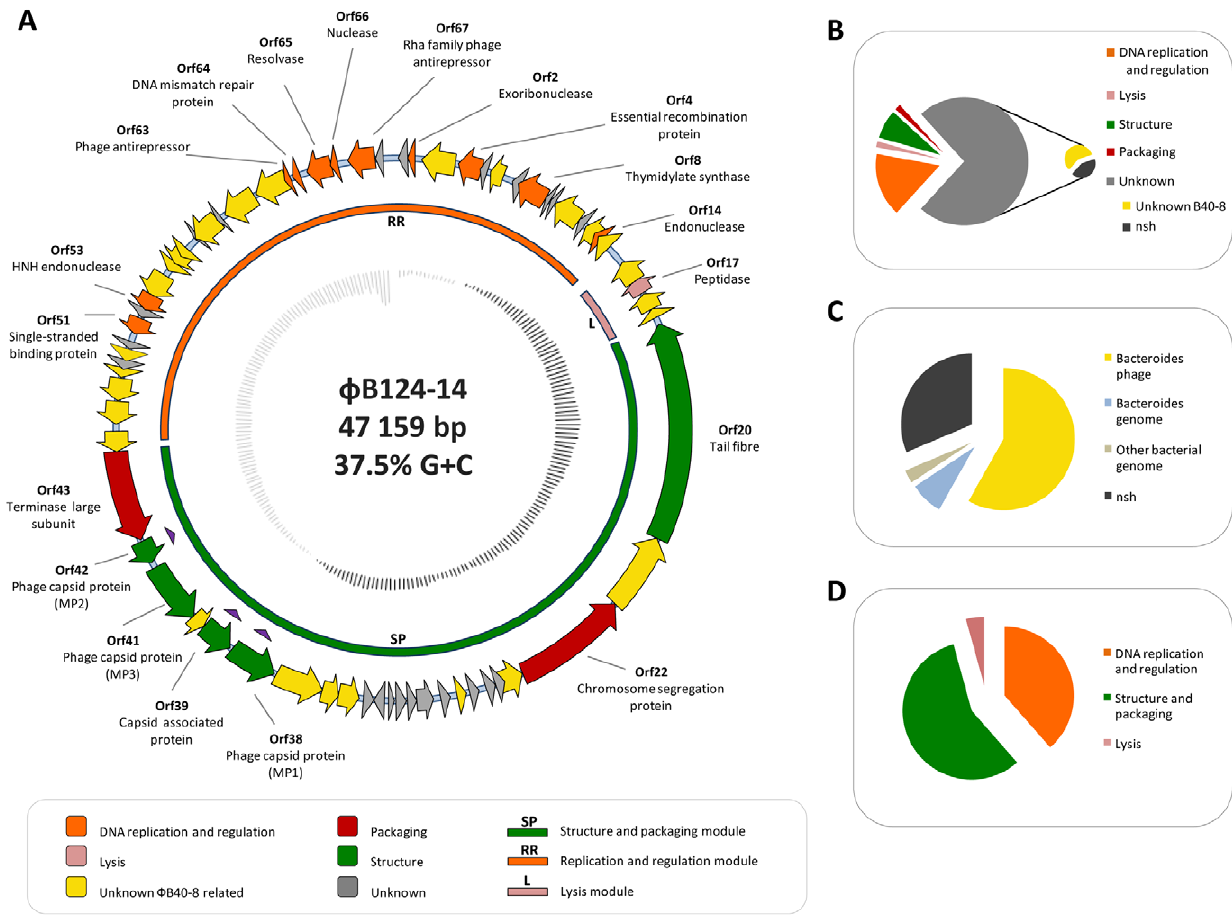
Figure 2. Architecture and characteristics of w B124-14 genome. A. Physical map of W B124-14 genome. Outer track: Position and orientation of each predicted ORF. Block arrows represent individual ORFs and indicate direction of transcription. ORF colour indicates functional assignment based on BlastP and conserved domain searches (minimum 20% identity, and an e-value of 1e 2 5 or lower), as well as analysis of the phage proteome, as described in the figure legend. ORFs marked with purple triangles indicate ORF function has been confirmed through LC-MS/MS analysis of the mature phage proteome (See Figure 4). Middle track: Bars represent location of proposed functional gene clusters and ORFs belonging to each cluster. Colours of bars indicate putative role of each gene cluster in phage replication, based on predicted functions of member ORFs. Inner track: G + C content: dark grey lines = above average genome G + C content; light grey lines = below average genome G + C content. B. Percentage of ORFs assigned to each functional category, including unassigned ORFs. ORFs of unknown function are further broken down in a secondary pie chart to illustrate those with homologues in the other available Bacteroides phage genome ( w B40-8), and those with no significant homology (nsh) to any sequences present in public databases encompassed by the nr dataset. C. Percentage of w B124-14 ORFs with highest homology (based on top hits by bit score in BlastP searches) to sequences of various phylogenetic origin. Only hits generating e values of 1e 2 5 or lower were considered significant in this analysis. nsh – no significant homology. D. Illustrates the percentage of predicted ORFs assigned to each of the three predicted functional modules in the w B124-14 genome.